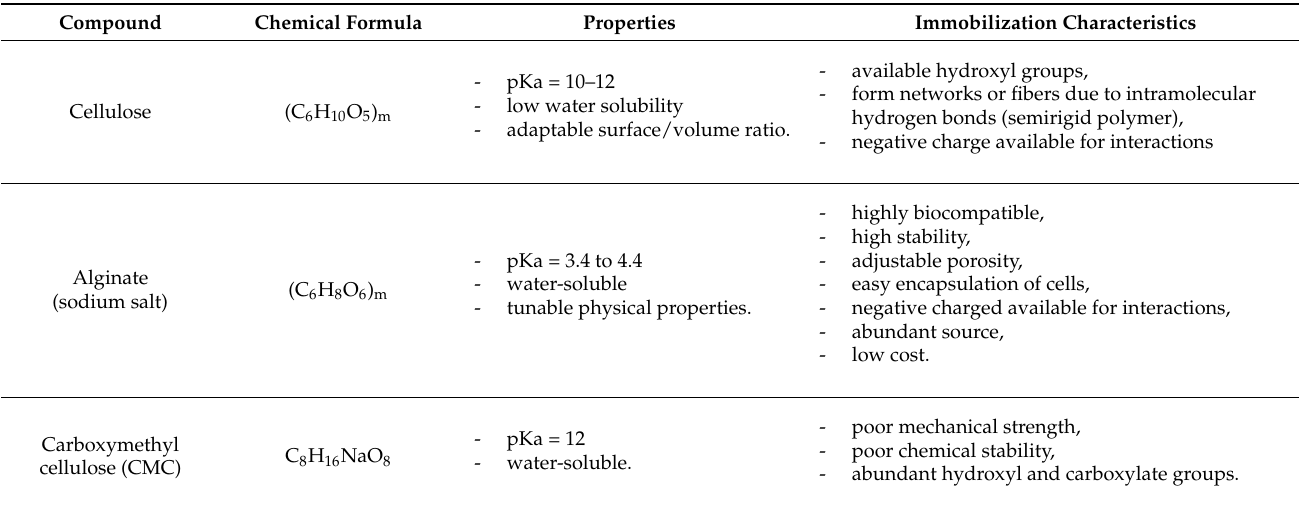
Table 3. Polysaccharides used as support for biosorbents